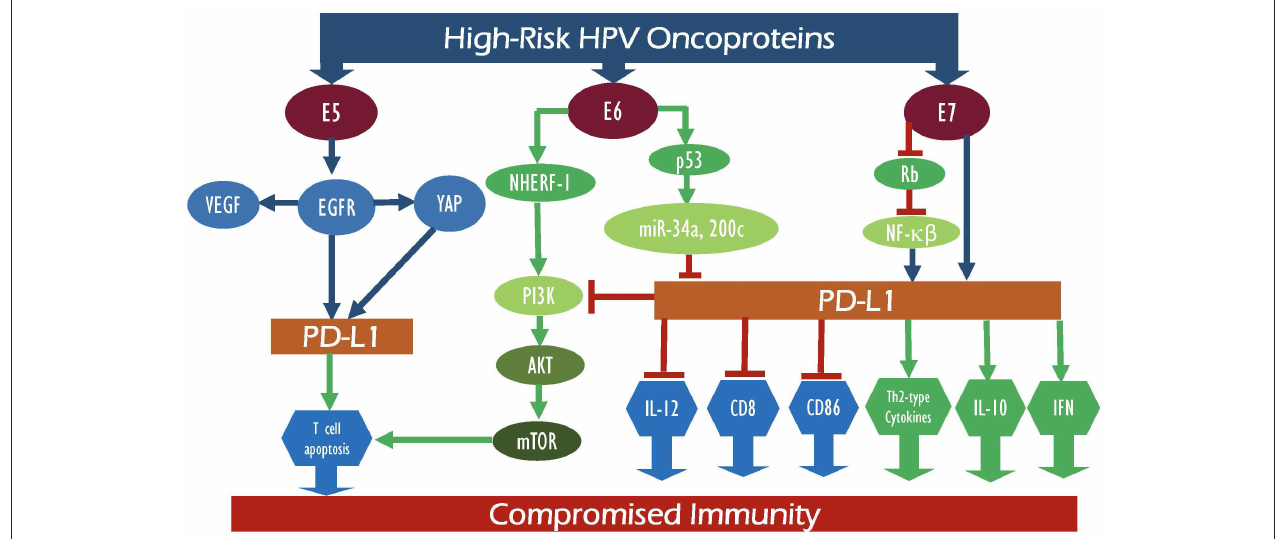
FIGURE 1 | Schematic outline showing the potential interaction between E5, E6, and E7 of high-risk HPV oncoproteins with their intermediate proteins as well as their signaling pathways which can deregulate PD-1 and PD-L1 expression patterns, consequently leading to compromised immunity.